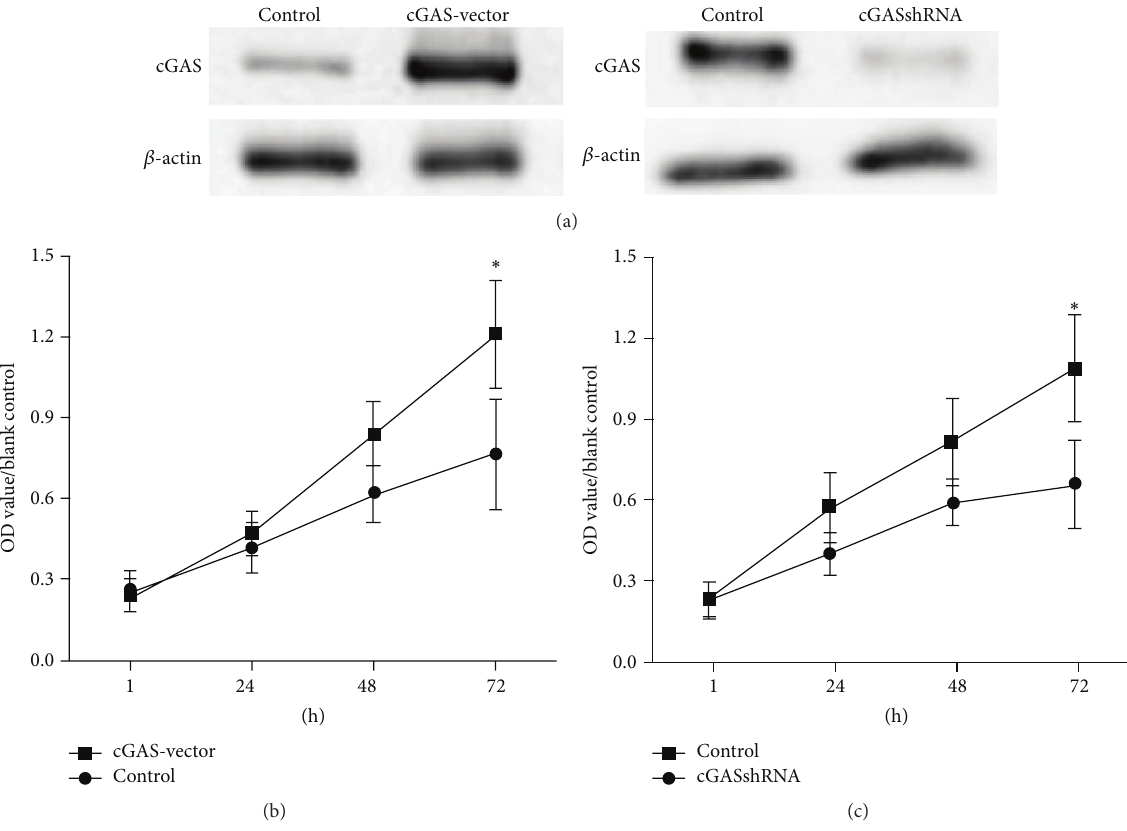
Figure 3: Effects of cGAS on RA FLS proliferation. (a) The transfection of cGAS expression vector enhanced cGAS protein levels, while the transfection of cGAS shRNA markedly reduced the protein levels of cGAS in the presence of TNF 𝛼 stimulation for 30 min. (b) and (c) MTS assay showed that cGAS overexpression dramatically increased the proliferation of RA FLS, whereas cGAS knockdown reduced the proliferation of FLS. ∗ 𝑃 < 0.01